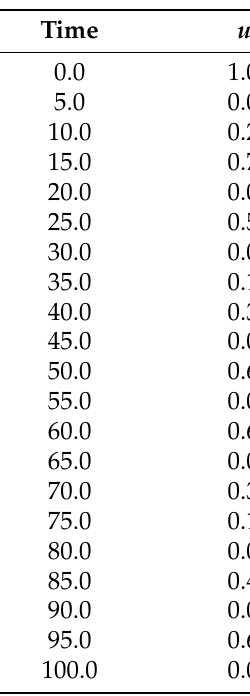
Table 3. The solution of (3) at α = 1.